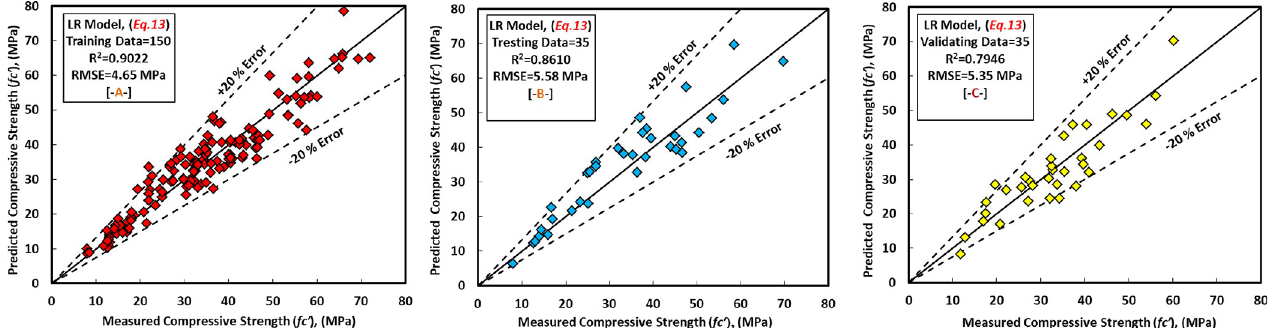
Fig 13. Comparison between measured and predicted compressive strength of GGBS/FA-GPC mixture using LR model, (a) training data, (b) testing data, (c) validating data.